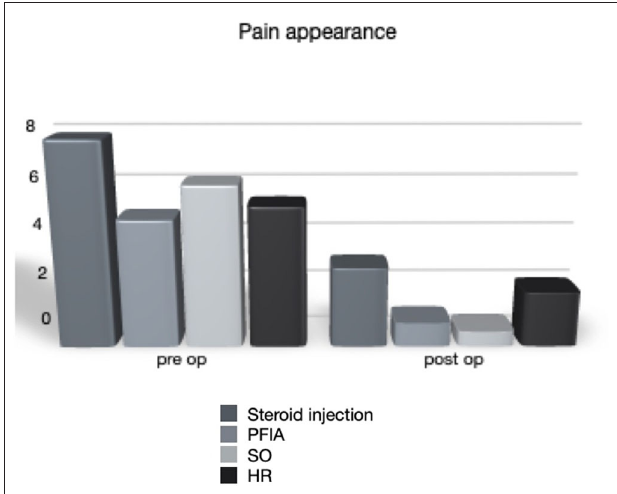
FIGURE 3 | Pain appearance before and after the treatment.